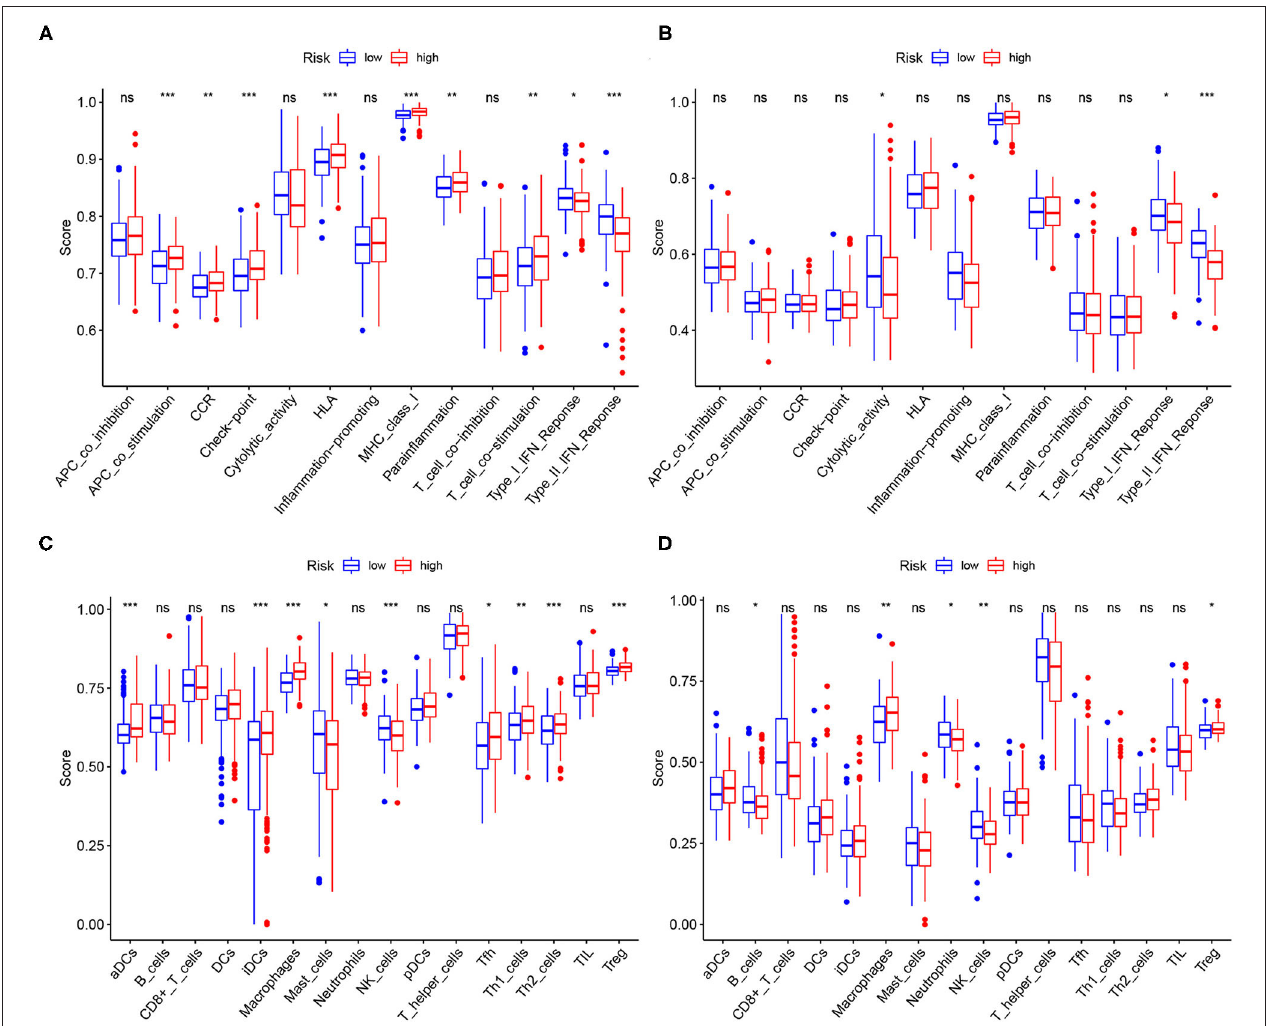
FIGURE 9 | Relationships between the risk score, immune infiltration cells, and immune functions. The high-risk scores were positively correlated with infiltration of the macrophages, natural killer (NK) cells, and regulatory T (Treg) cells both in (A) the TCGA dataset and (B) the ICGC dataset. The high-risk scores were positively correlated with type I IFN response and type II IFN response both in (C) the TCGA dataset and (D) the ICGC